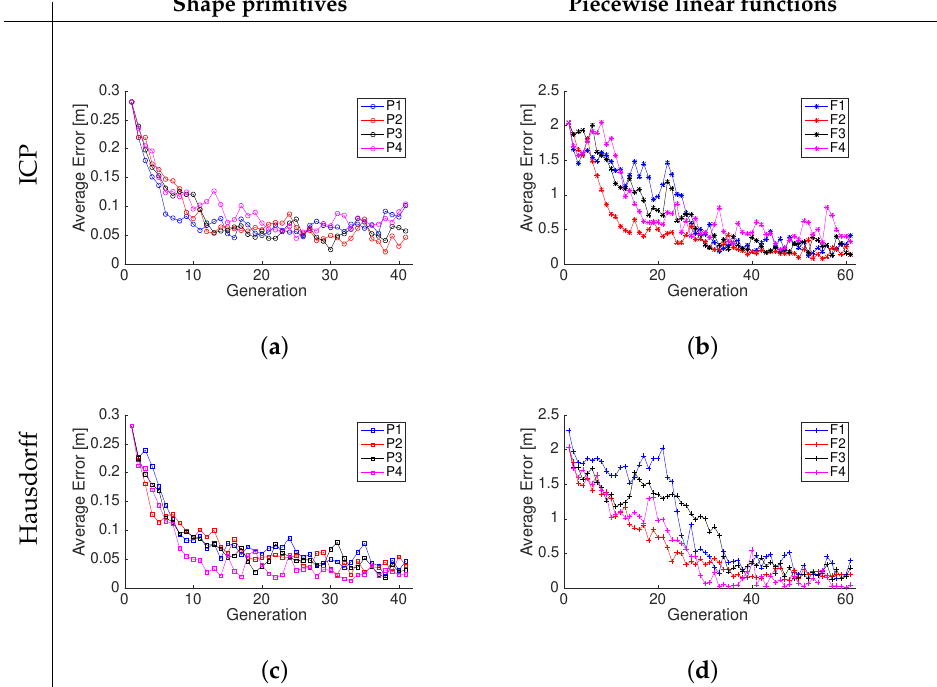
Figure 6. Convergence of the square root of the trace of the matching error covariance matrix for shape primitives ( a , c ) and piecewise linear functions ( b , d ) using ICP and Hausdorff matching,